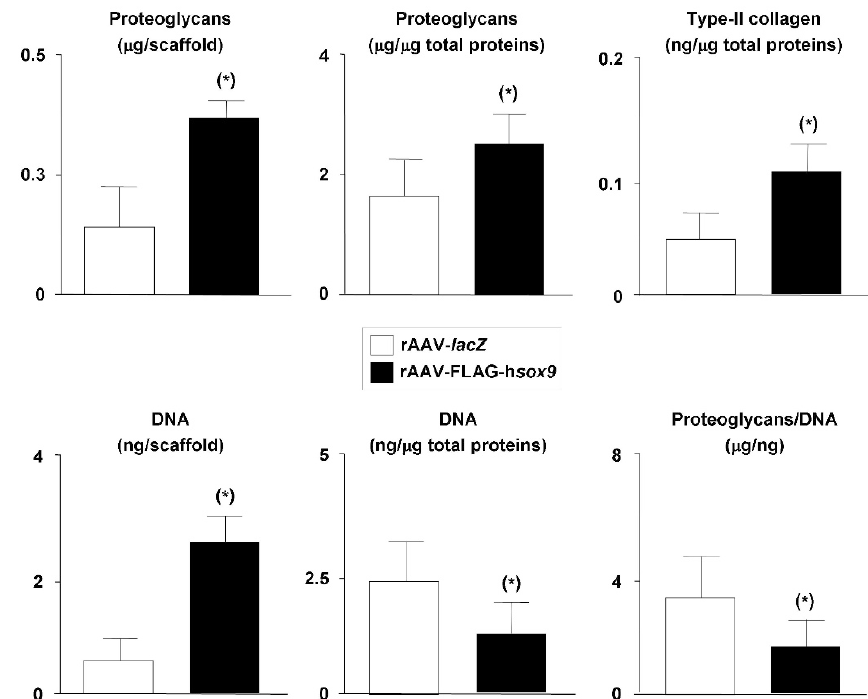
Figure 4 . Biochemical analyses in hydrodynamic cultures of rAAV-transduced hMSCs seeded in fibrin-PU scaffolds. Cells were transduced, seeded in PU scaffolds, and placed in rotating bioreactors as described in the Figures 1–3 and in Materials and Methods. The samples were processed after 21 days to monitor the proteoglycan contents by dimethylmethylene blue dye method, the type-II collagen contents by ELISA, and the DNA contents using Hoechst 33258 in the constructs. * Statistically significant compared with rAAV- lacZ .